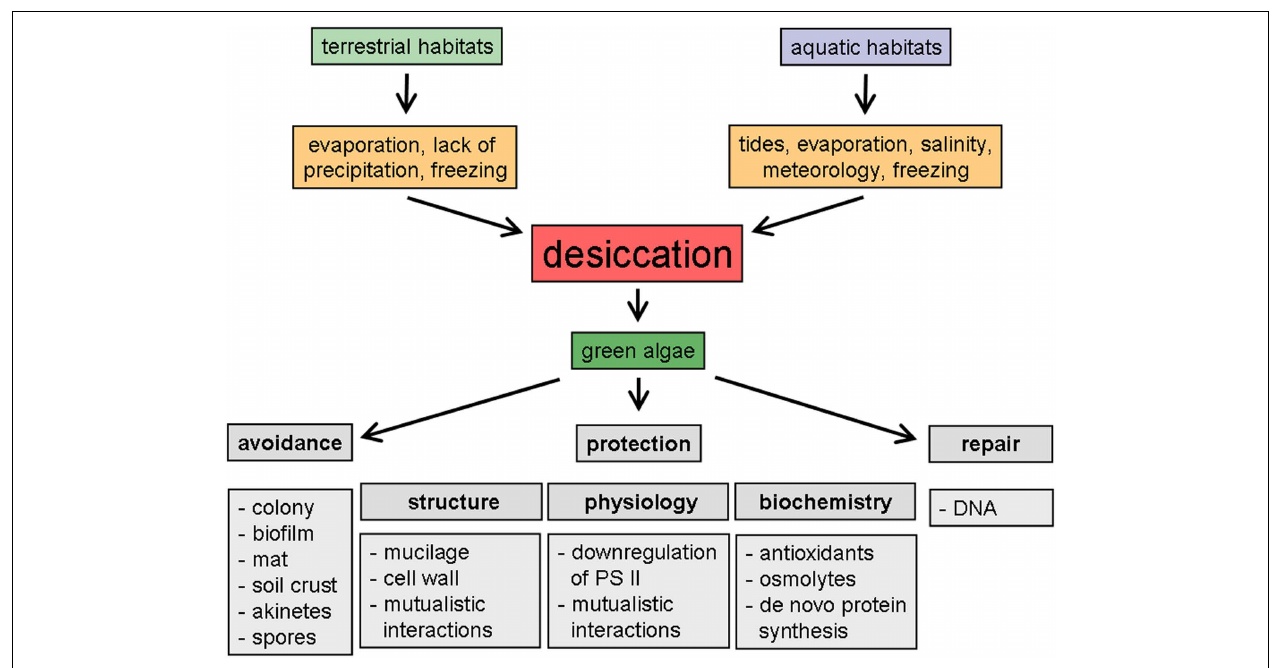
FIGURE 1 | Schematic representation of desiccation-induced phenomena in green algae from different habitats.